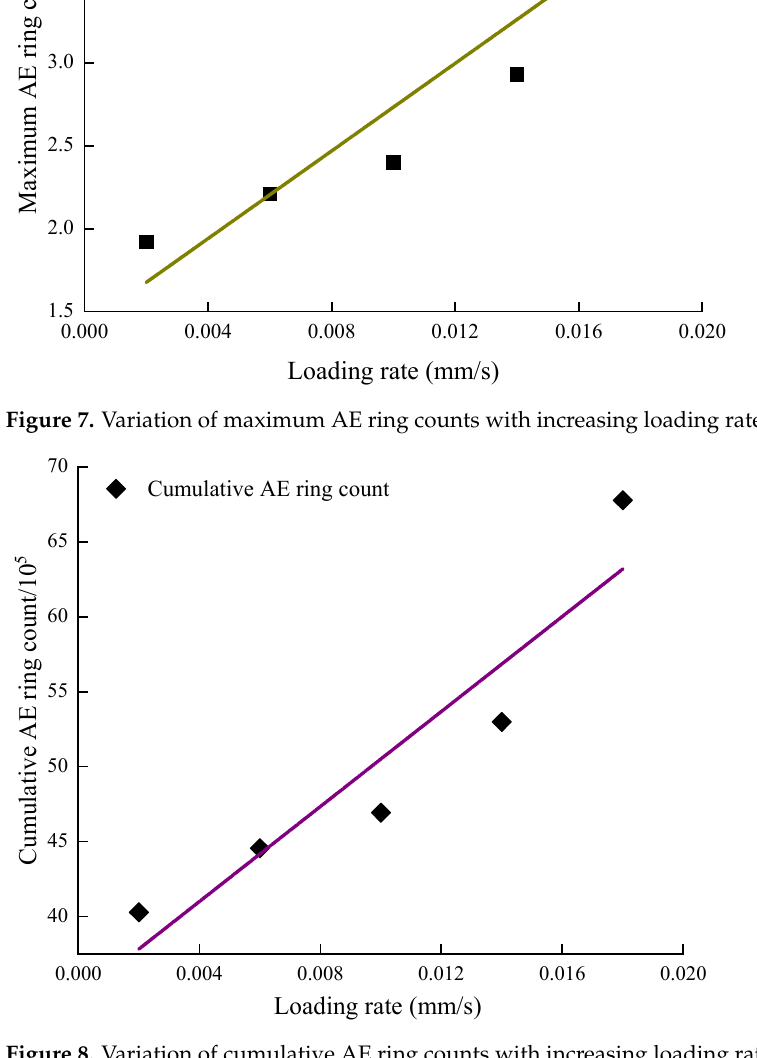
Figure 8. Variation of cumulative AE ring counts with increasing loading rate .